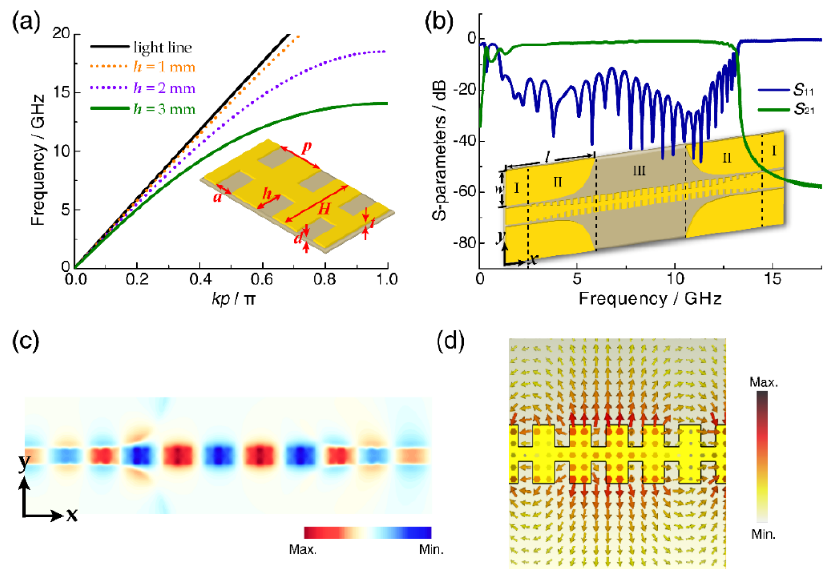
Figure 1. Prototype design and characteristics of SSPP waveguide based on two-sided metallic strips. ( a ) Dispersion curves have varying groove depths h , and the other geometrical parameters are fixed: p = 5 mm, a = 2 mm, H = 8 mm, t = 0.018 mm, and d = 0.5 mm. ( b ) Transmission ( S 21 ) and reflection coefficients ( S 11 ) of SSPP waveguide, whose entire structure is shown in the inset. ( c ) Simulated electric field distribution at 6.01 GHz in the x–y plane at 1.5 mm above the structure. ( d ) Electric field vectors of partial SSPP waveguide structure in the x–y plane. The color scales of the arrows indicate the field amplitudes.